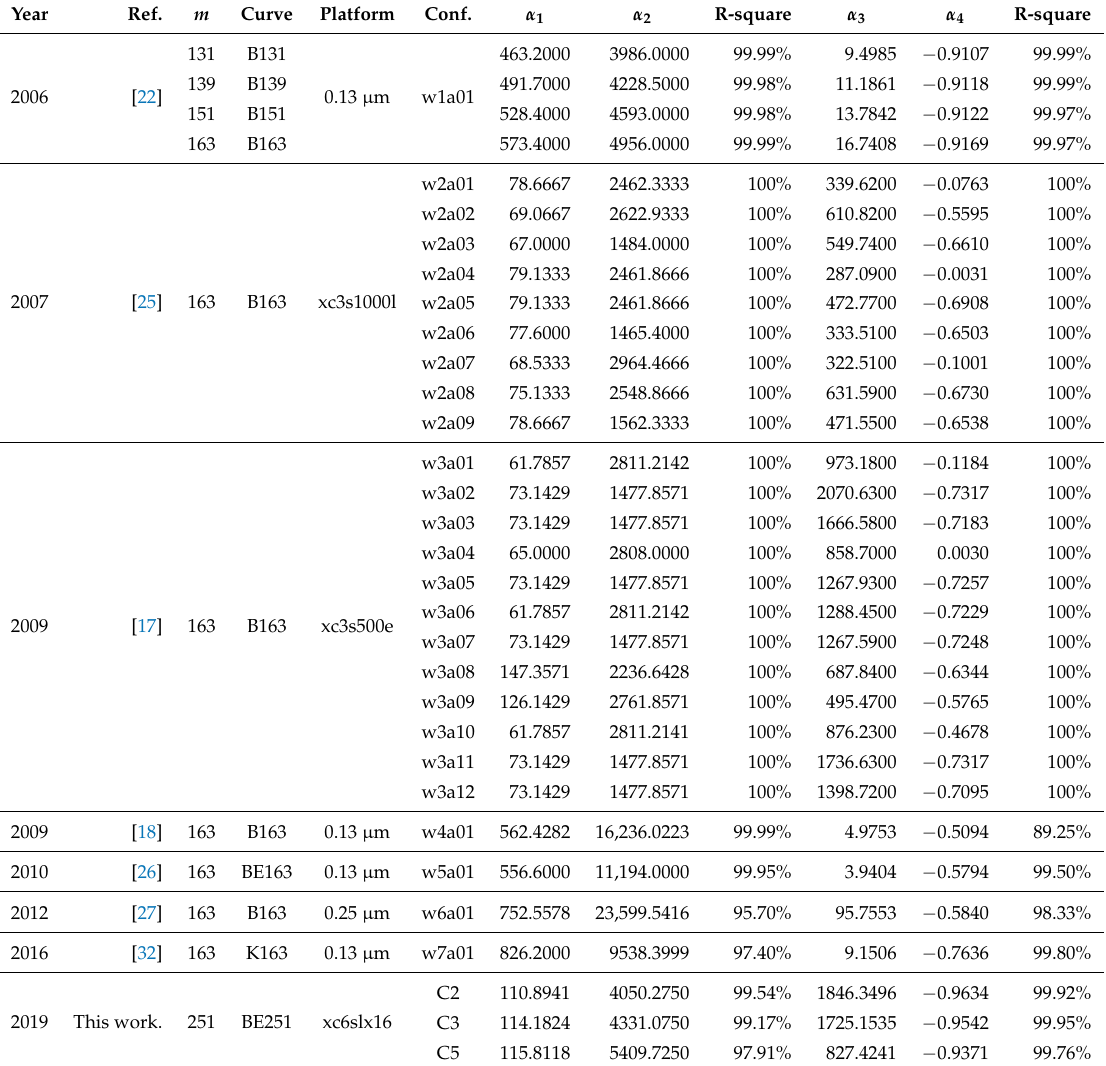
Table 9. Adjusted coefficients for the efficiency model of each configuration. The R-square result is provided for the adjustment of the hardware and the energy consumption